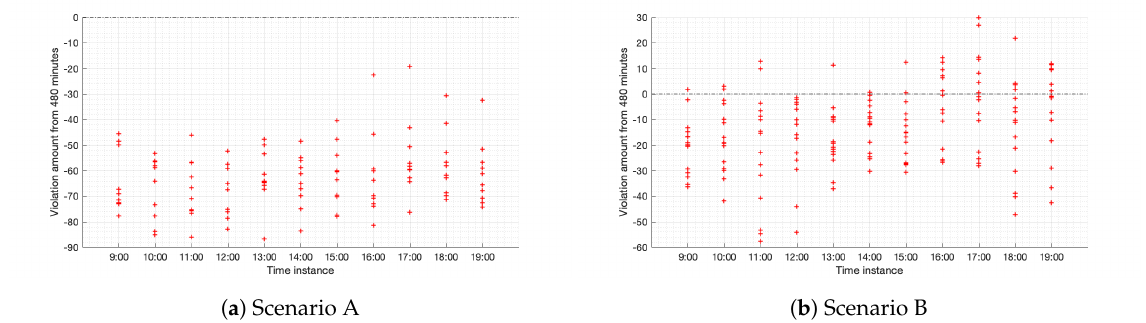
Figure 11. Transferring route solution from a fixed time instance to actual traffic time when the working time limit in the fixed time instance was set to the optimal working time τ ∗